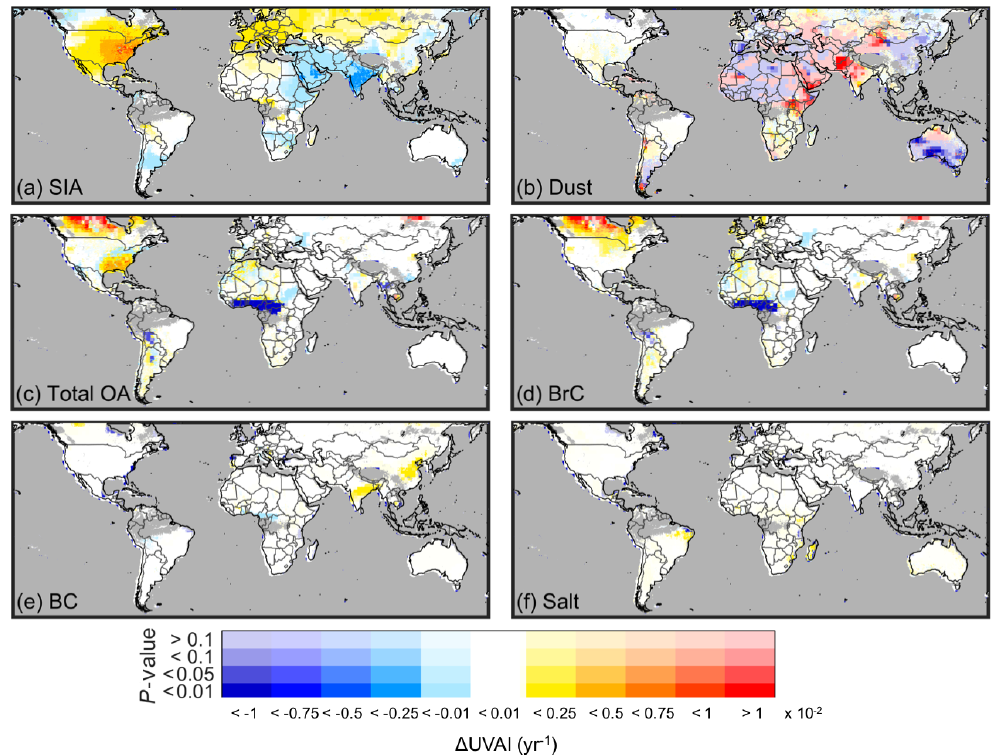
Figure 9. Change in simulated UVAI values due to the 2005–2015 trends in (a) secondary inorganic aerosols (SIA), (b) dust, (c) total organic aerosol (OA), (d) brown carbon (BrC), (e) black carbon (BC), and (f) sea salt from the GEOS-Chem simulation. Grey indicates persistent cloud fraction greater than